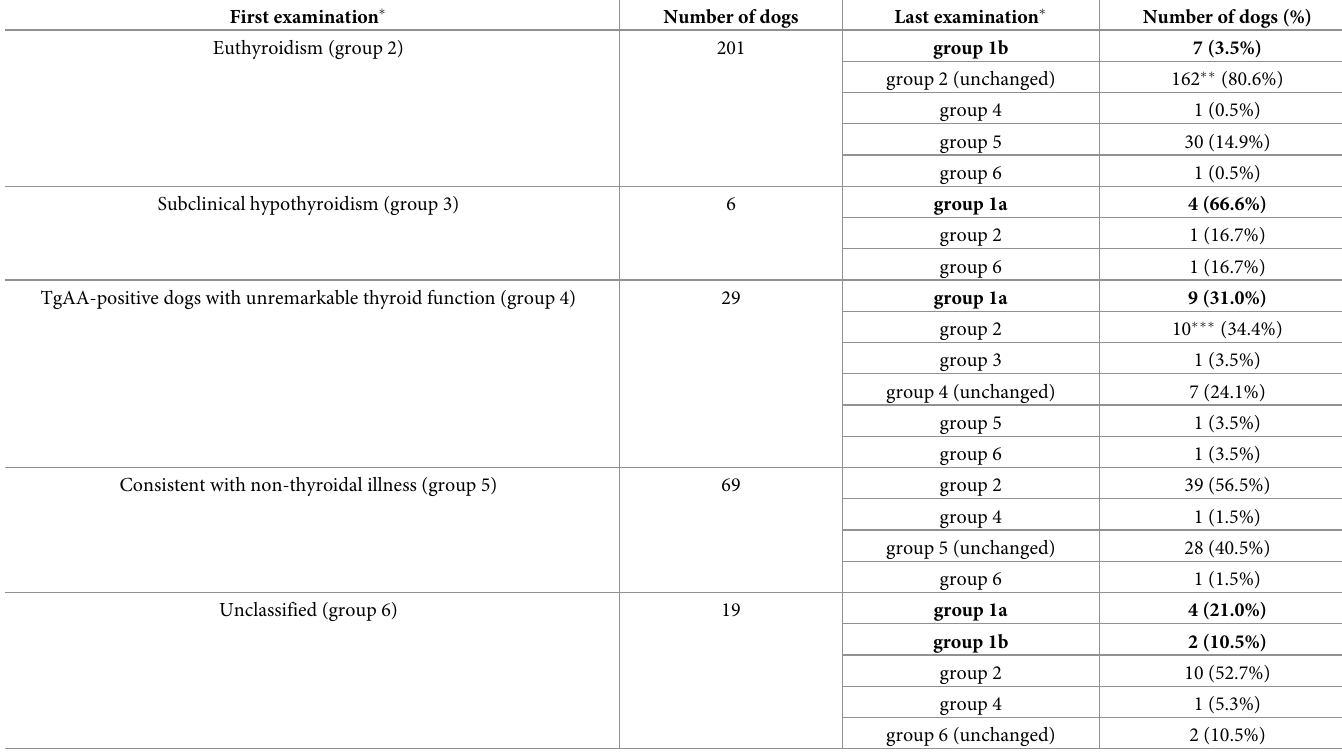
Table 3. Outcome of 324 dogs in which follow-up data were available. The first and third columns provide the classification based on the first examination and the clas- sification based on the last available examination, respectively. First examination �